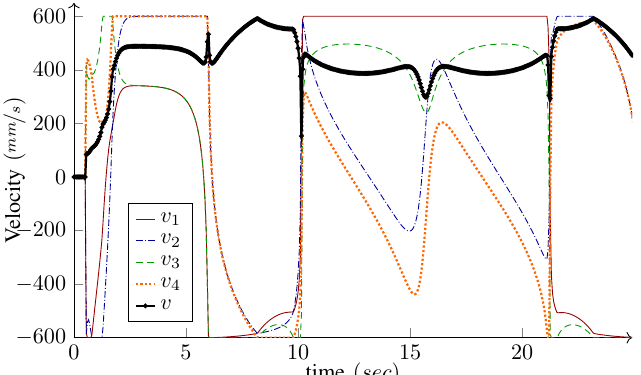
Figure 10. Simulation : Driving velocities v i , and the base speed v , for path-following of a WMR with four Swedish wheels depicted in Figure 8.